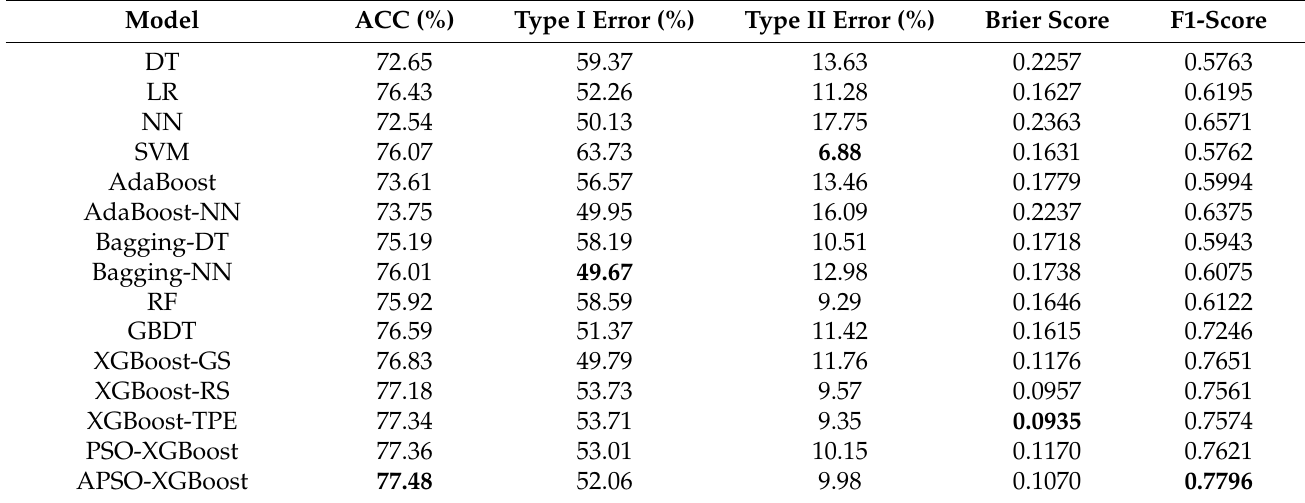
Table 7. Results of the measured performance of models on the German data set.